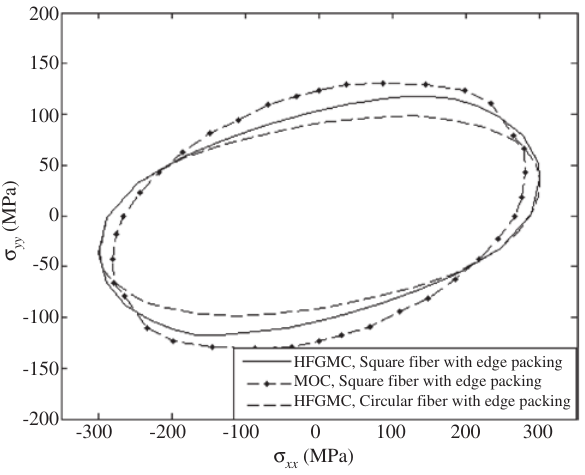
Figure 3 Comparison of the initial yield surface of boron/Al composites.